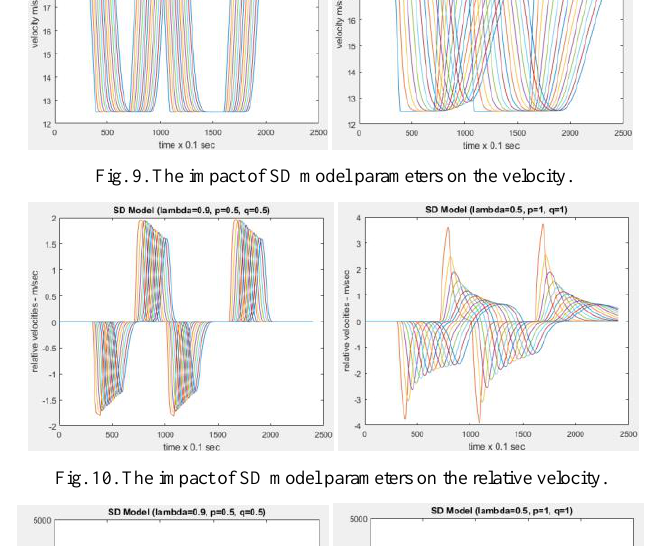
Fig. 6. The distances of the followed drones.